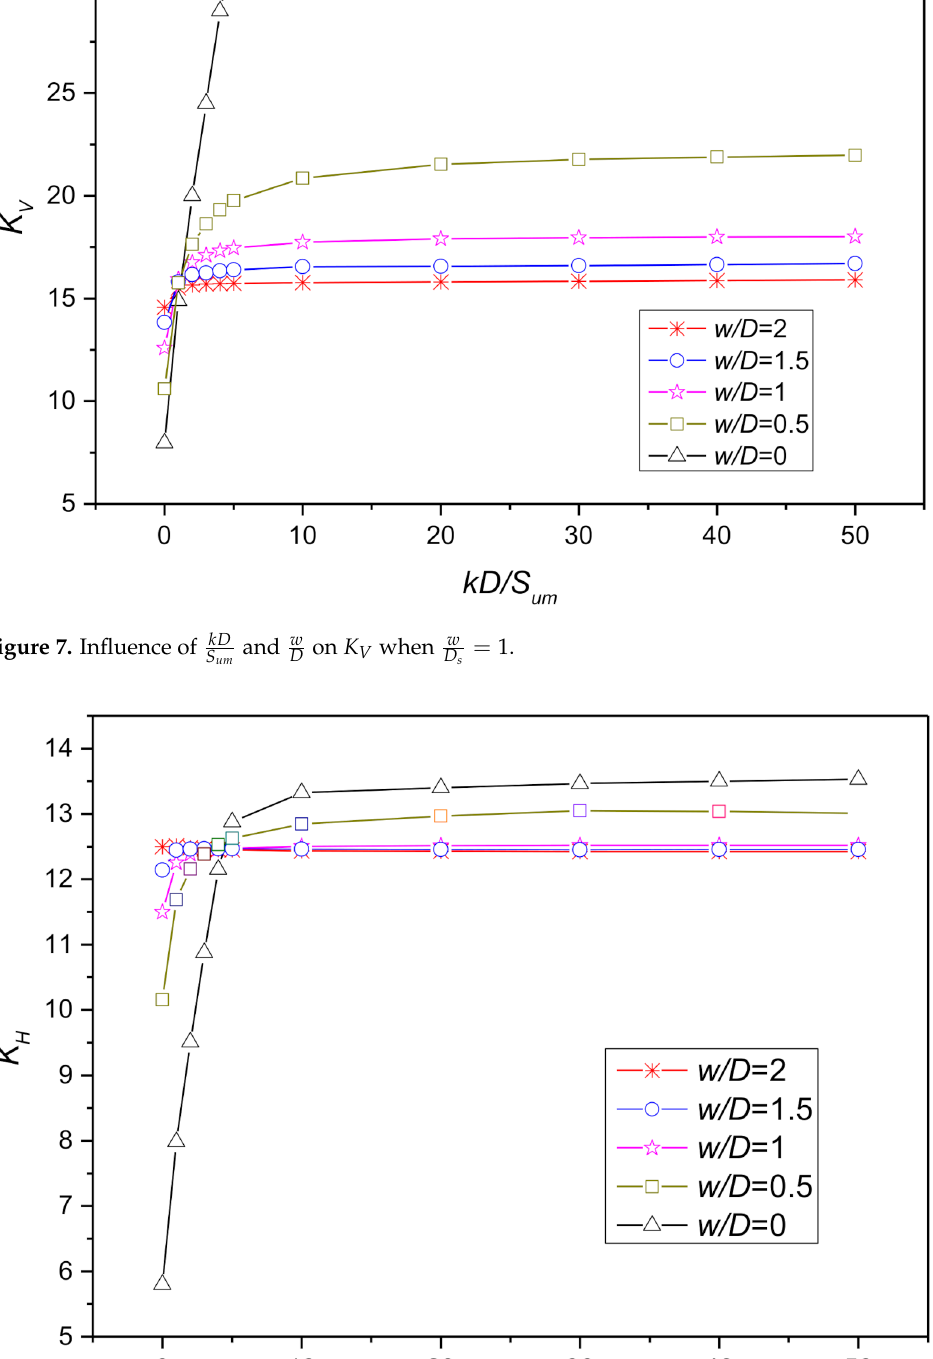
Figure 8. Influence of kD